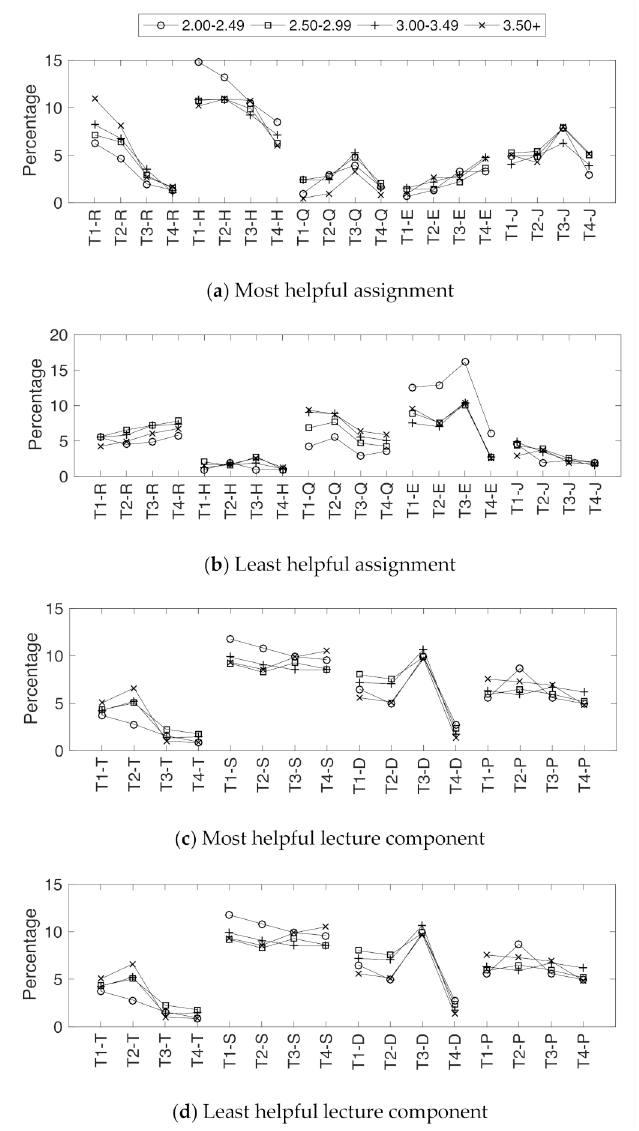
Figure 4. Comparison of model category signatures for students in different GPA bins. T1–T4 = sit- uational teaching categories; R = readings; H = homework; Q = quizzes; E = exams; J = projects; T = theory; S = problem-solving; D = discussion; P =